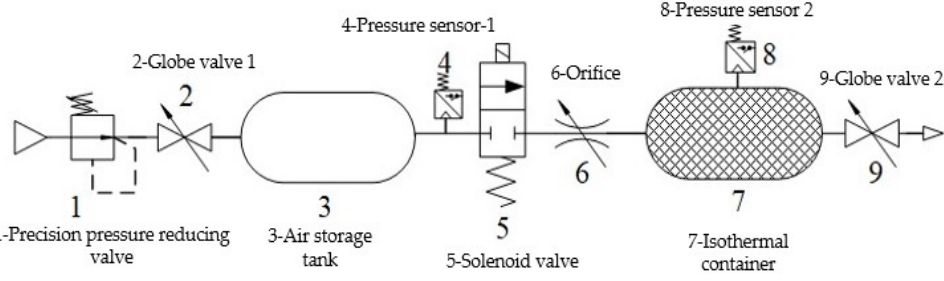
Figure 8. Block diagram of inflation test.